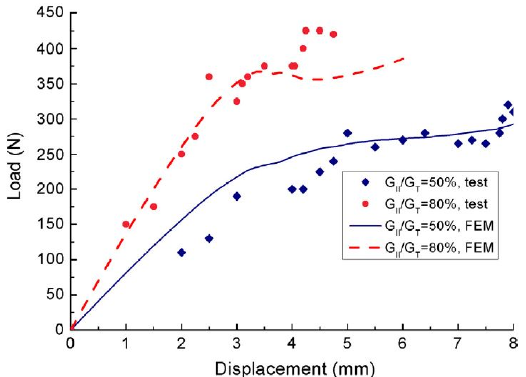
Figure 67. Force–displacement curves for cohesive model compared with experiment (G II / G Total = 50% and 80%, CFRP z-Pins)